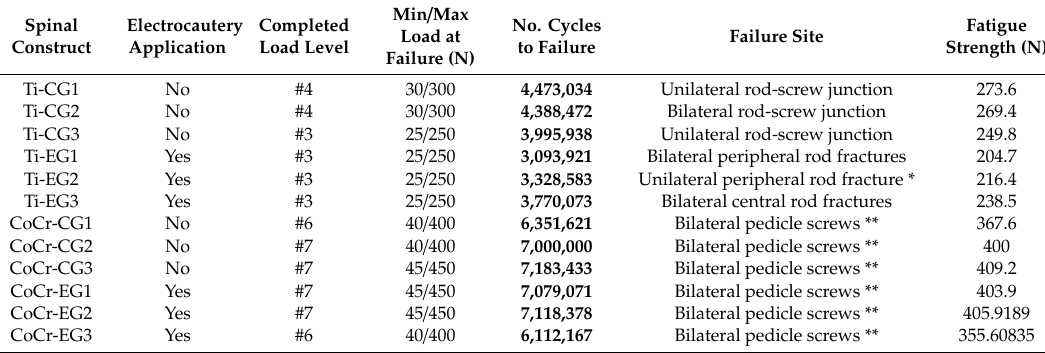
Table 2. Summary of the dynamic biomechanical test results.